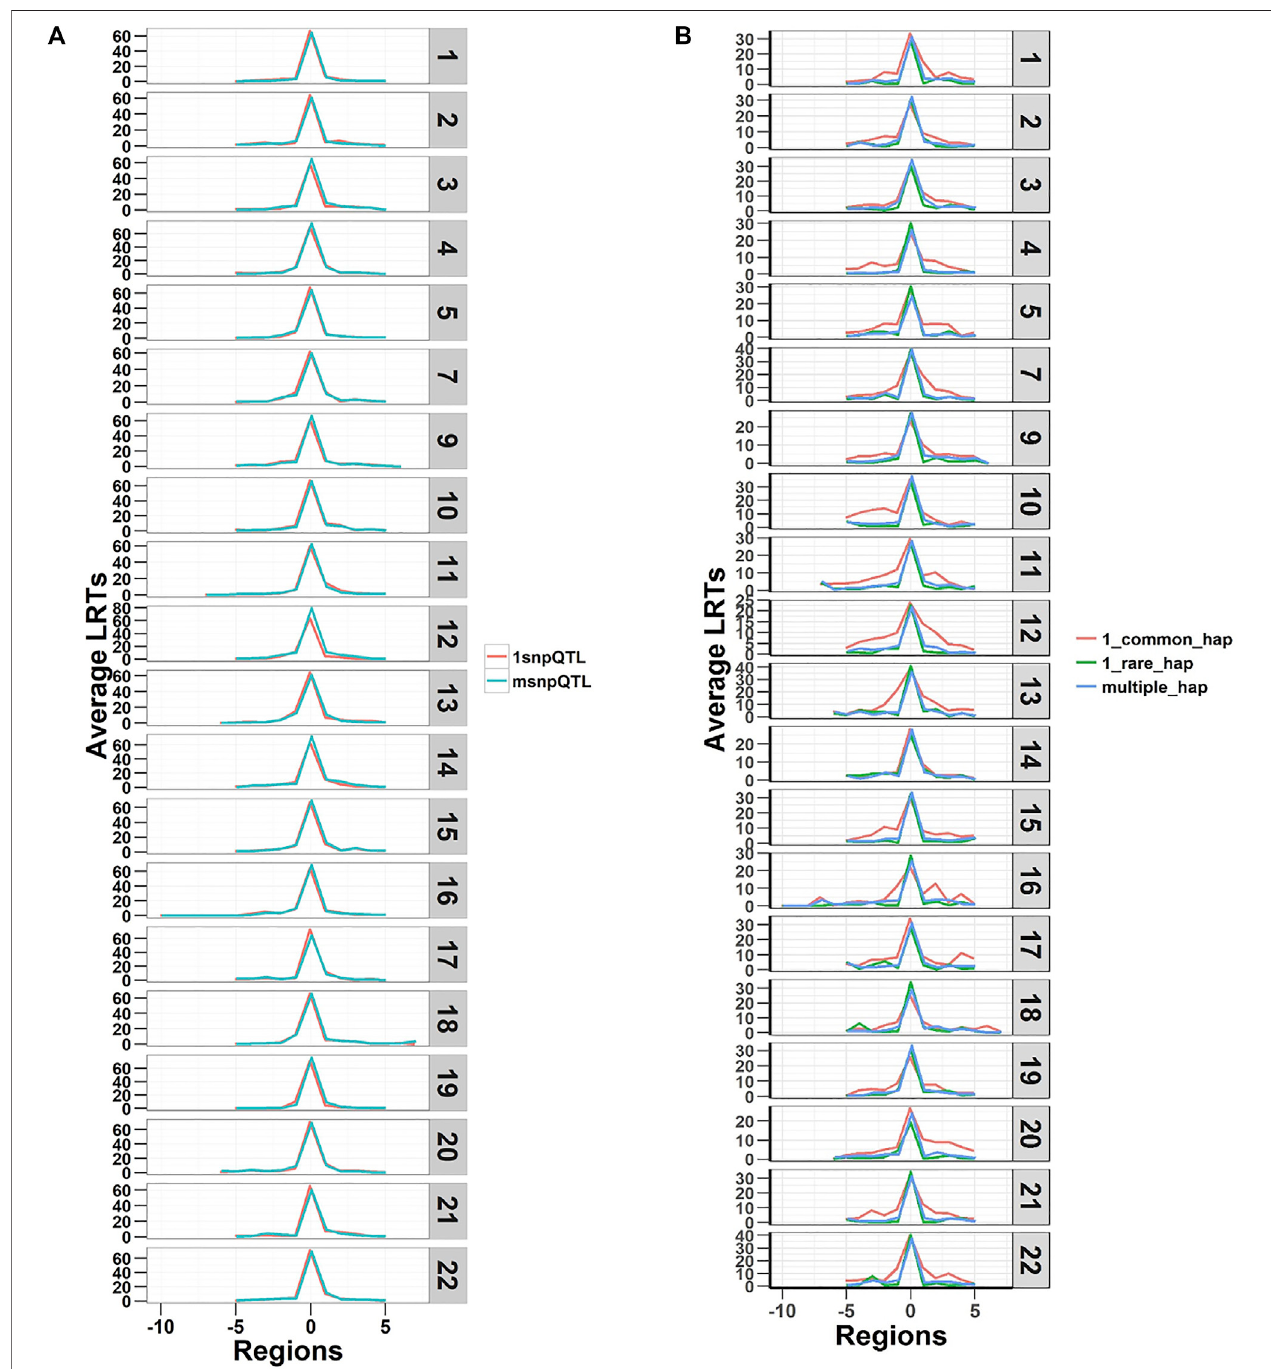
FIGURE 2 | Plots of Likelihood ratio test (LRT) statistics at each QTL locus and fi ve regions either side averaged for the 20 simulations of each of the fi ve QTL phenotypes. Plot (A) is SNP QTL phenotypes analysed using the SNP-RHM and plot (B) is the haplotype QTL phenotypes analysed using the Hap-RHM. Both models can capture the simulated QTL effects for their respective SNP and haplotype